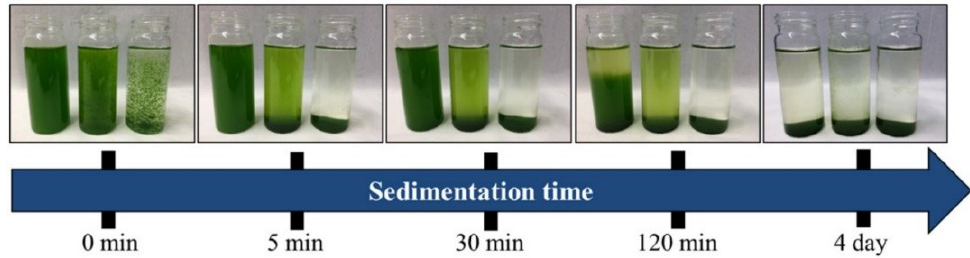
Figure 2. Auto-flocculation harvesting of algal biomass. Three vials contain algal samples cultured in different nitrate concentrations: ( left ) 0.5×; ( middle ) 1× (original); and ( right ) 2×. Reprinted from Reference [33], distributed under the terms of the Creative Commons Attribution License.